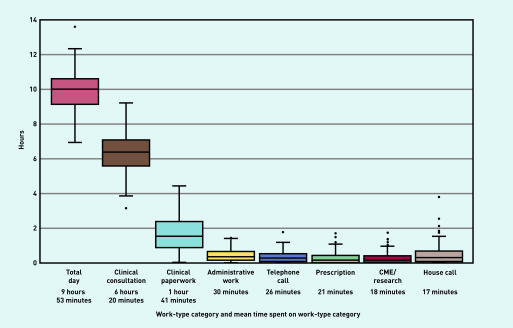
Boxplot demonstrating the breakdown of daily activity according to work-type categories for the total population. CME = Continuous Medical Education.